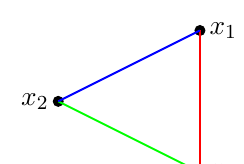
Figure 1 . The three solutions x 1 , x 2 , x 3 to x 3 + fx + g = 0 are plotted at a generic smooth point. We define the cycles π such that the red line segment denotes π i π 2 and the blue line segment denotes π 3